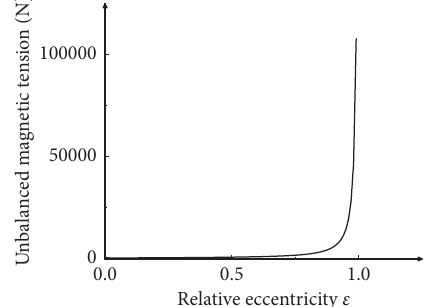
Figure 5: The relationship between relative eccentricity and magnetic force of gas